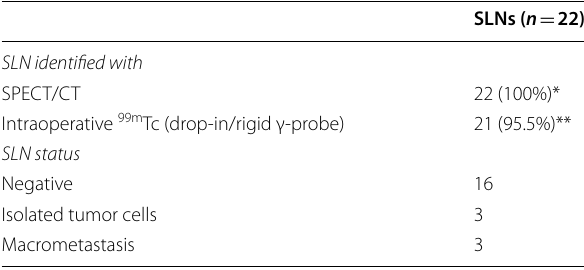
Table 2 Radioguided sentinel lymph node detection: outcomes per sentinel lymph node